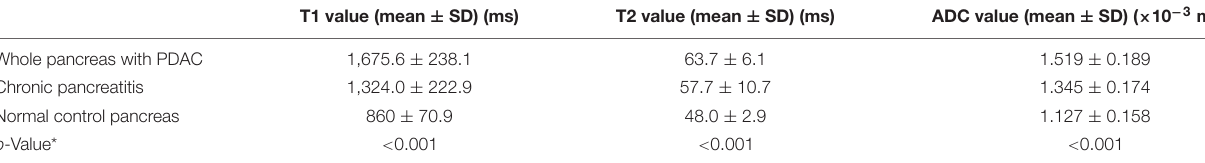
TABLE 2 | T1, T2, and ADC values of the whole pancreas with PDAC, chronic pancreatitis (CP), and normal control pancreas.